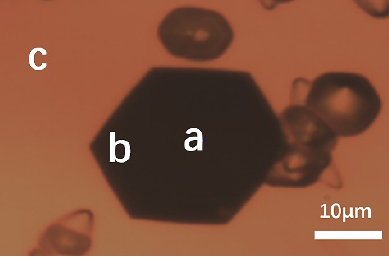
Figure 11. Different positions of testing: ( a ) center of a micropipe; ( b ) edge of a micropipe; ( c ) outside of a micropipe.